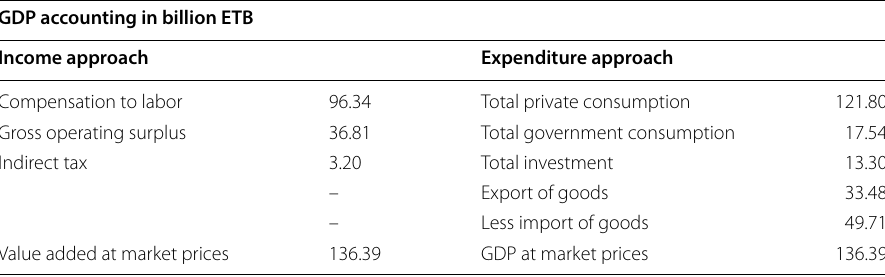
Table 10 GDP, demand and supply accounting for the Oromia economy. Source: author’s computation using